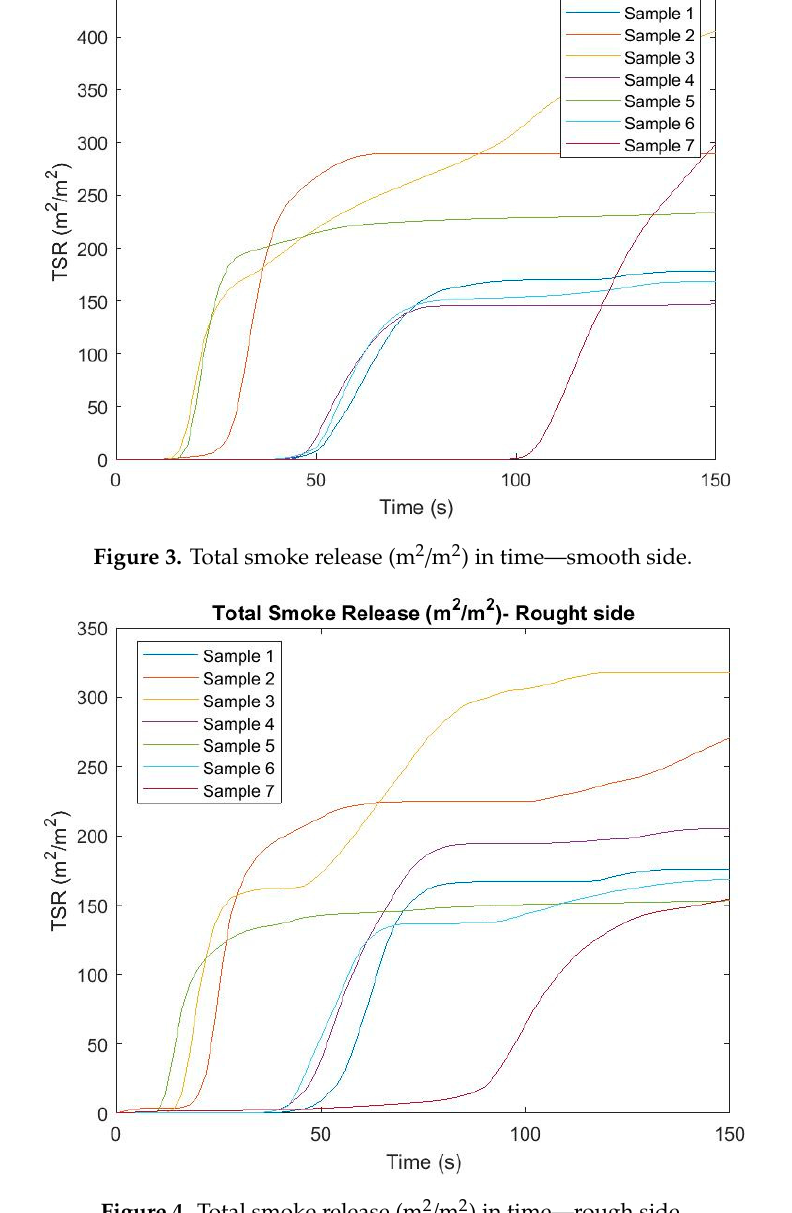
Figure 4. Total smoke release (m 2 /m 2 ) in time—rough side.